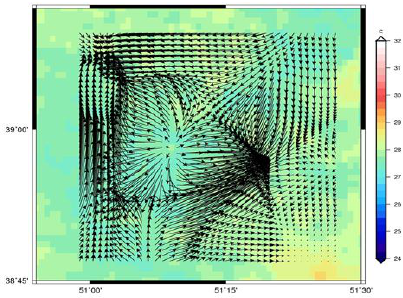
Figure 27. Results of Lucas/Kanade plotted on SST (Win=5, Sigma=3) For smoothness condition in α=3 (Fig 24), some of curved motions are ignored relative to α=0.1 (Fig 22) but the flows in Figure 24 are more continuous and smooth. The results of Lucas/Kanade are more smooth when Win increases and by decreasing Sigma (Sigma=1) it can obtain real flows (Fig 26), but in Figure 27 when Sigma increases (Sigma=3), the reality decreases and the extracted flows are more smooth. It suggests for sea surface currents that are like jet currents and when they move like curved lines it’s better to decrease Sigma. Each vector for example in figure 23 has different direction with its match (Figure 24) and when α increases, the norm of vectors increase too regards to size of vectors. Using arccos function for calculating angular differences can provide a map that shows the most disturbances for extracted directions.